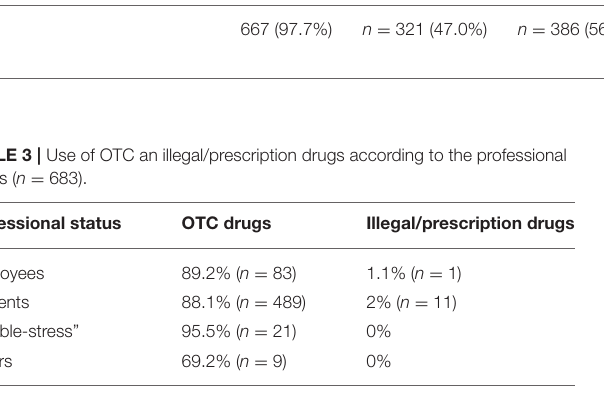
TABLE 2 | General knowledge of pharmacological neuroenhancement according to the type of source where this knowledge came from. Have you ever heard about neuroenhancement drugs?